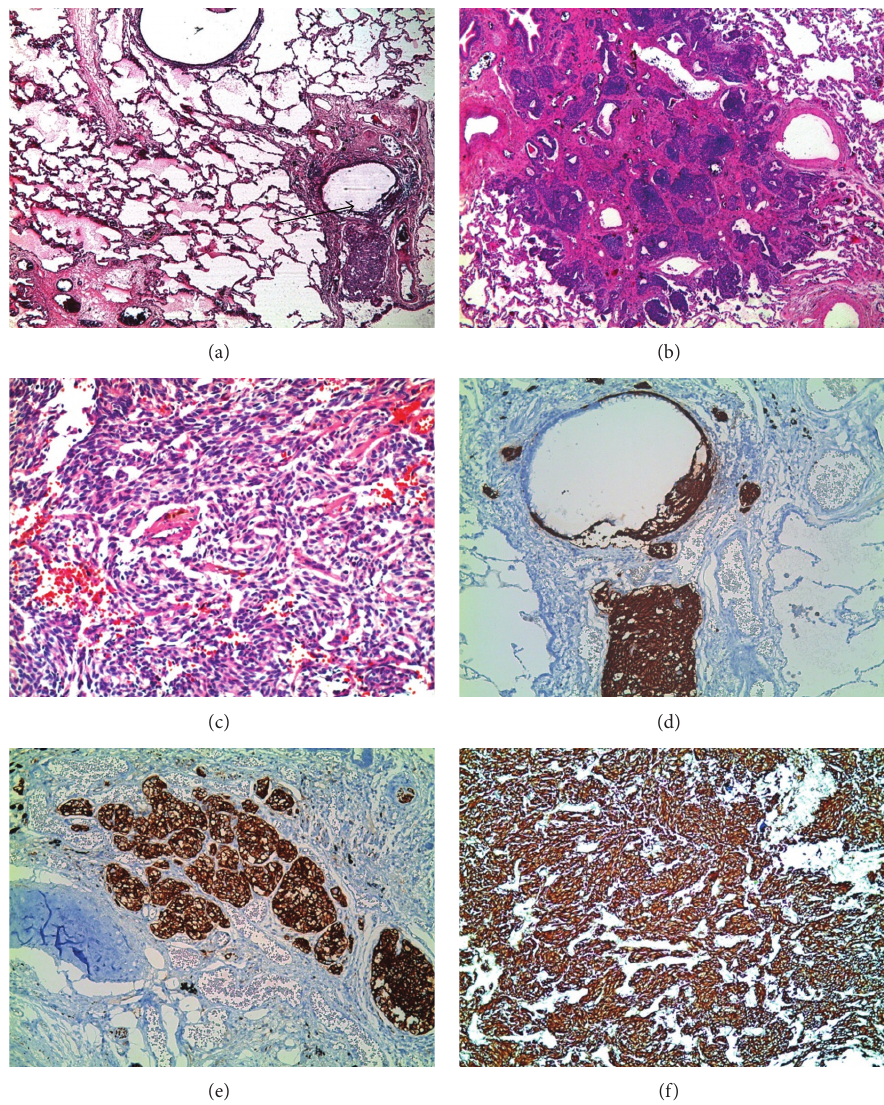
Figure 2: (a) Linear and nodular proliferation of neuroendocrine cells within terminal bronchiole submucosal layer and tumorlets (HE × 2.5). (b) Tumorlet (HE × 4). (c) Carcinoid tumor (HE × 20). (d) ChrA reactivity of the same area in (a) (ChrA × 10). (e) CD56 positivity in a tumorlet (CD56 × 10). (f) Carcinoid tumor cells with strong SYNP positivity (SYNP ×